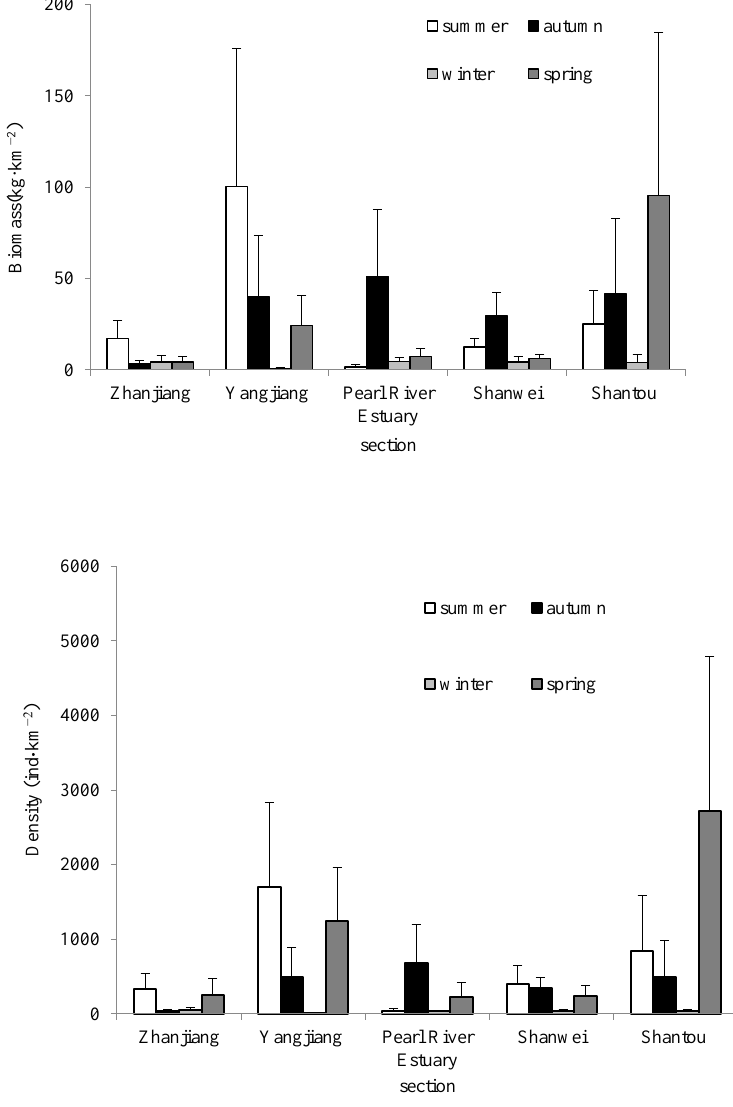
Figure 4. Temporal and spatial variation in average biomass ( upper ) and density ( lower ) of Evynnis cardinalis across the northern continental shelf, South China Sea. Error bars indicate SE. Relationships between average biomass, density, season, and section were explored using cluster analysis (Figure 5). There was no obvious pattern between location, season, and biomass. Seasonal distributions in biomass and density at Pearl River Estuary and Shanwei sections were most similar. Seasonal and spatial variation in biomass was ob- served, just like in density of Evynnis cardinalis . The Shantou section forms a self-contained cluster since it has the lowest similarity with other sections.